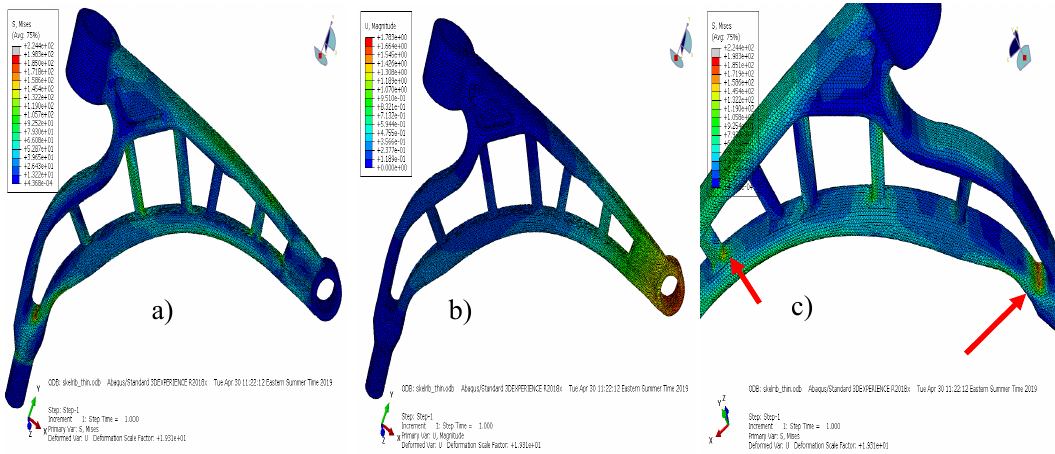
Figure 9. FEA of hollow design; ( a ) von Mises stress plot, ( b ) total displacement plot, ( c ) other view of Von Mises (VM) stress plot.